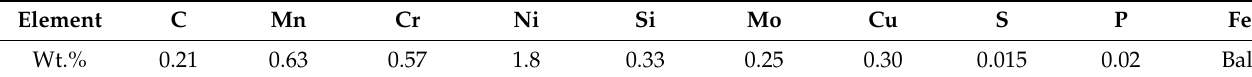
Table 2. The composition of 20CrNi2MoA.